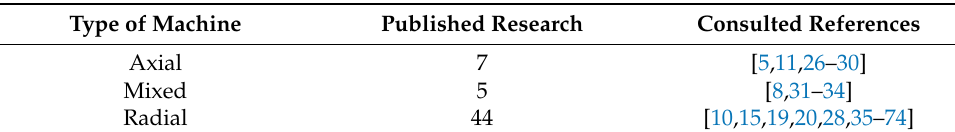
Table 1. Consulted researches.